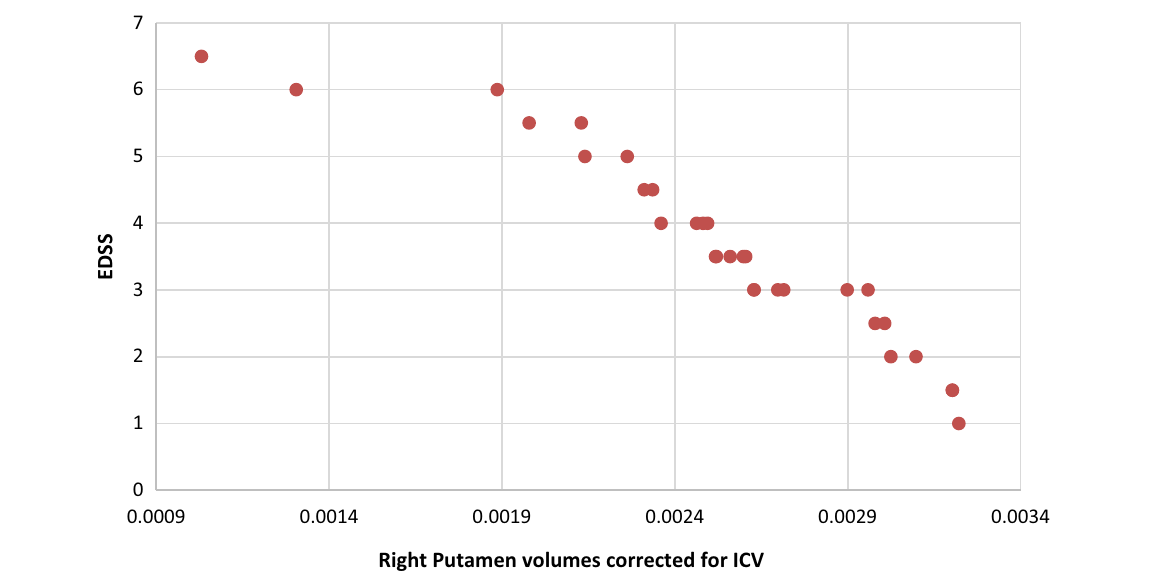
Fig. 2 Correlation between left and right putamen volumes and EDSS